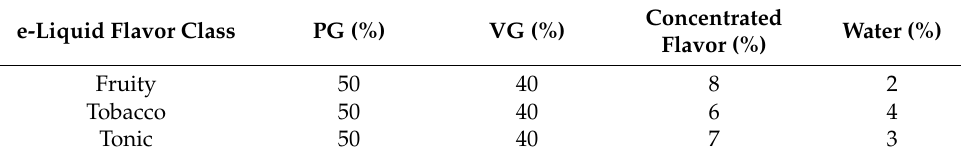
Table 6. Composition of the three classes of